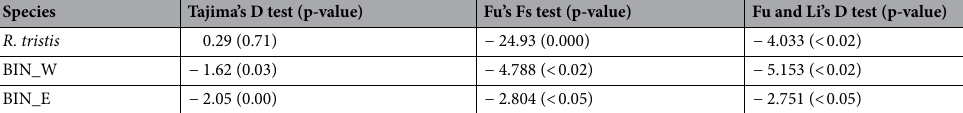
Table 3. R. tristis mtDNA COI 5 ′ neutrality tests with p-values for the whole dataset and two different BINs— BIN_W and